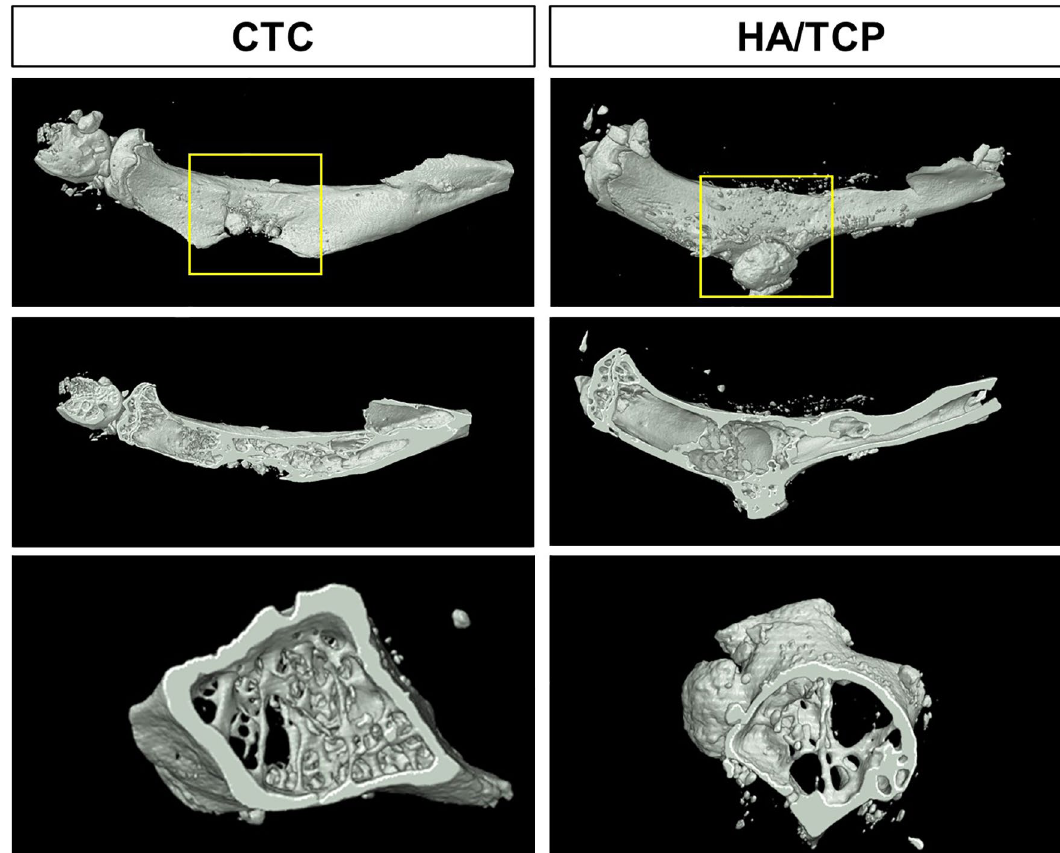
Figure 8. Three-dimensional reconstruction of bone defect repairing by the CTC and HA/TCP biomaterials at week 8 by micro-CT. The yellow boxes were chosen as a region of interest (ROI) to analyze the data of osteogenesis and trabecula.